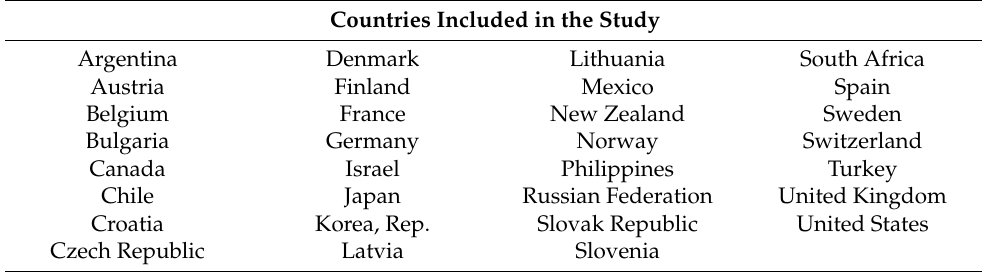
Table 1. Countries included in the study. Countries Included in the